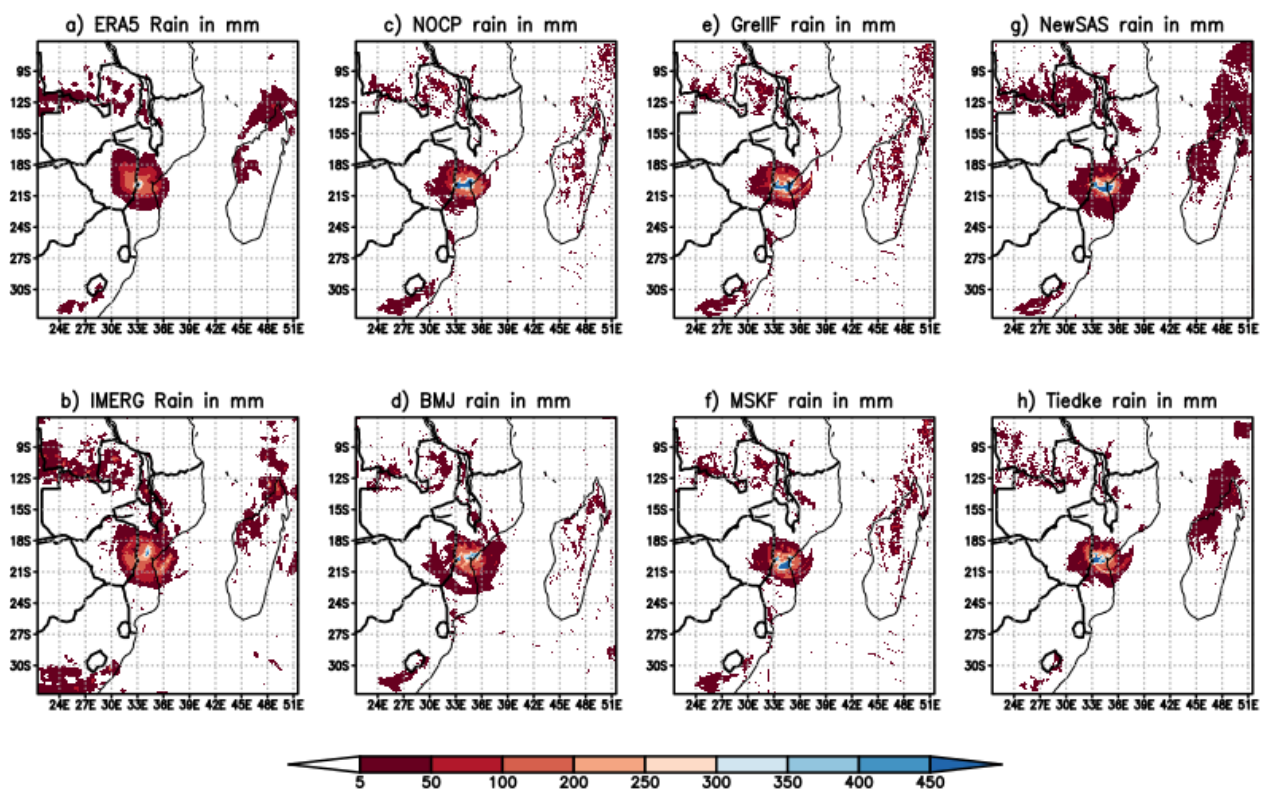
Figure 5. Same as in Figure 3 but for 15